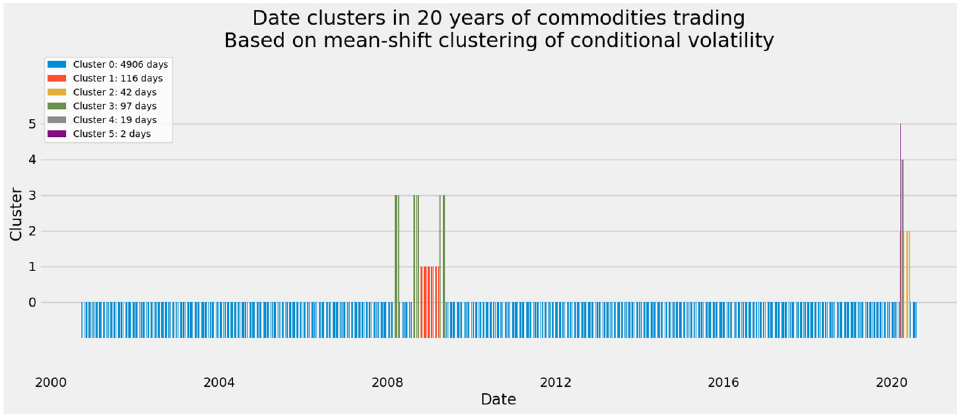
Figure 9. Mean-shift clustering of commodity markets—An ordered timeline. The dotted horizontal line in Figure 10 intersects five vertical branches. The comfort- able vertical distance on either side of 75 implies that 5 is a near-optimal number, if we are unwilling to abandon multiclass in favor of binary clustering. In any event, the logic of agglomeration makes it easy to rearrange the five clusters as two.